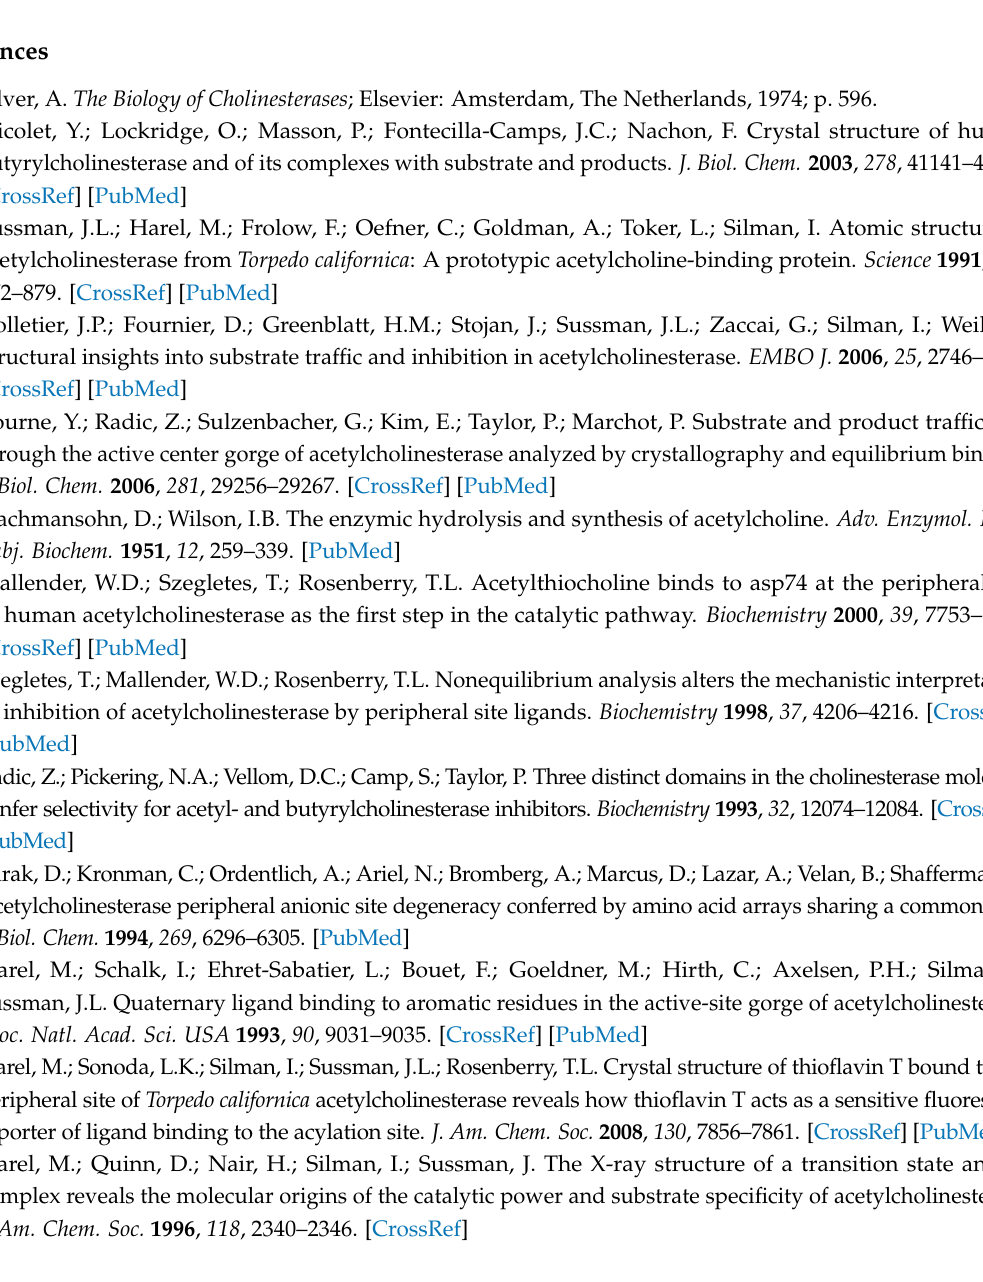
Supplementary Materials: Supplementary materials are available online. Figure S1: 2Fo-Fc electron density maps of the ligands; Figure S2: Representatives traces and fits of ITC experiments; Table S1: Data collection and refinement statistics; Table S2: Concentrations of ligand and protein used for ITC